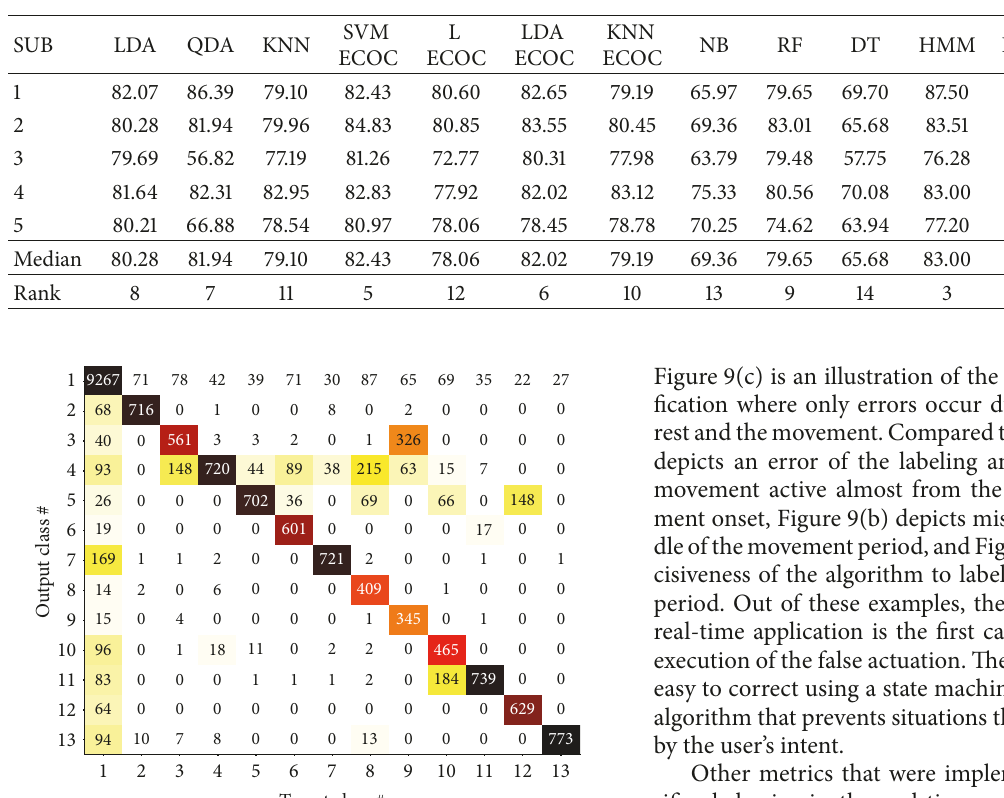
Table 2: Classifier accuracy in % for the different subjects and MAV feature.